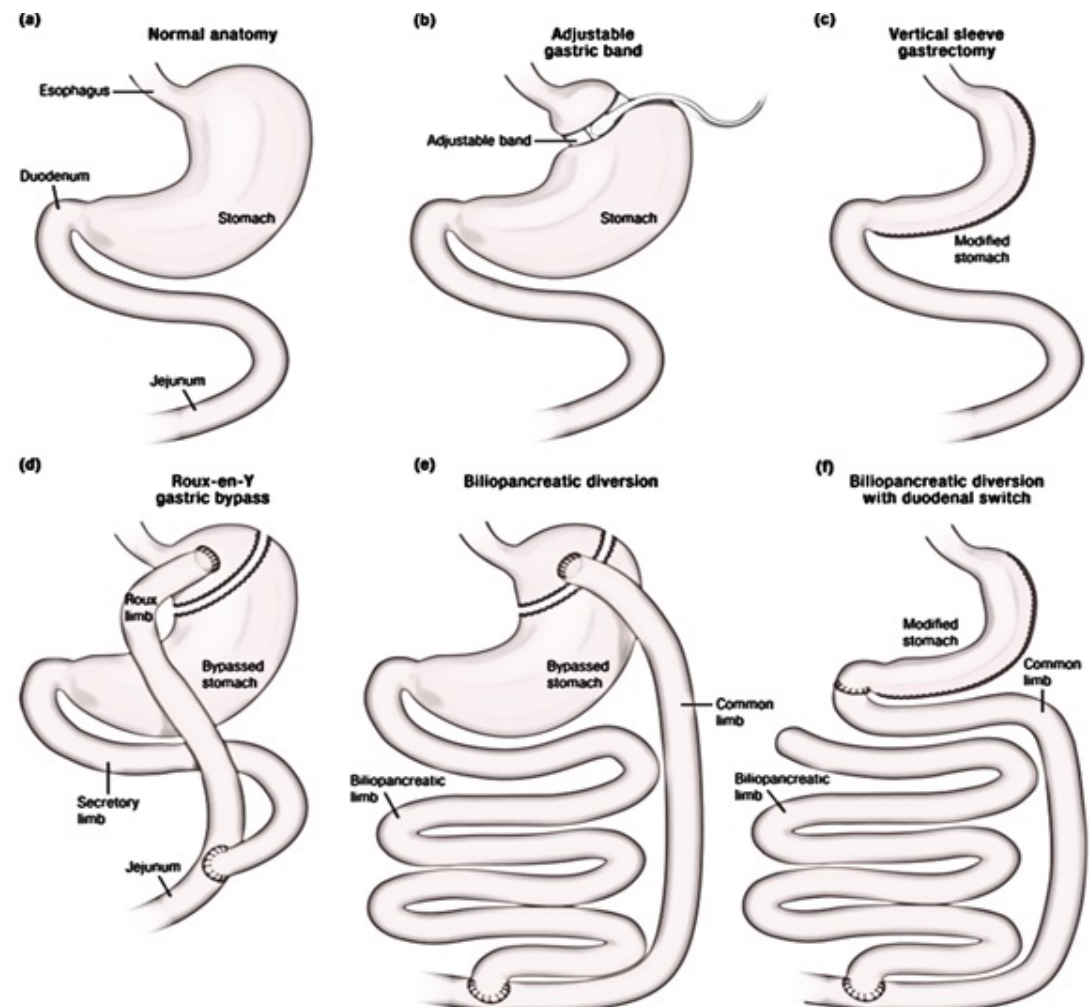
Figure 4. ( a ) Normal upper GI anatomy. Bariatric procedures: ( b ) Adjustable Gastric Banding (AGB); ( c ) Vertical Sleeve Gastrectomy (VSG); ( d ) Roux-en-Y gastric bypass (RYGB). ( e ) Biliary-Pancreatic Diversion. ( f ) Biliary-pancreatic Diversion with Duodenal Switch (BPD-DS) [73].